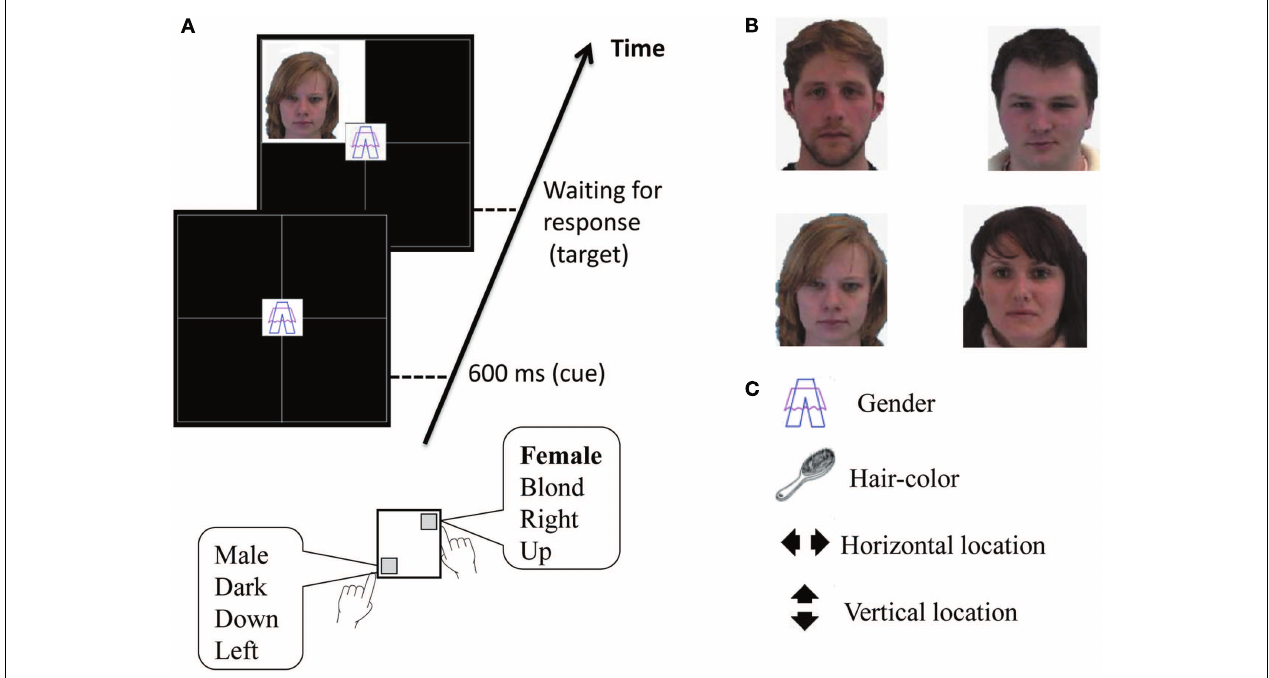
FIGURE 2 | Illustration of the Faces paradigm, based on Meiran et al. (2010). (A) Schematic representation of the events in a trial, including cue presentation, followed by target presentation; (B) the four target objects; (C) the cues for the four tasks.